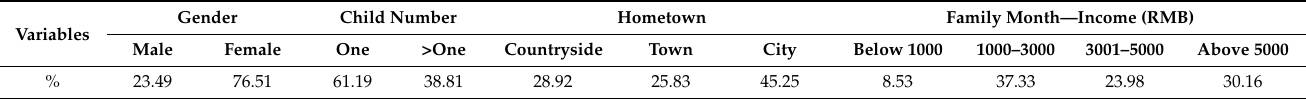
Table 1. Basic information of participants ( n =